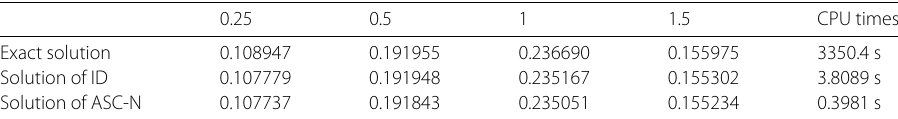
Table 1 Comparison of exact solution and numerical solutions